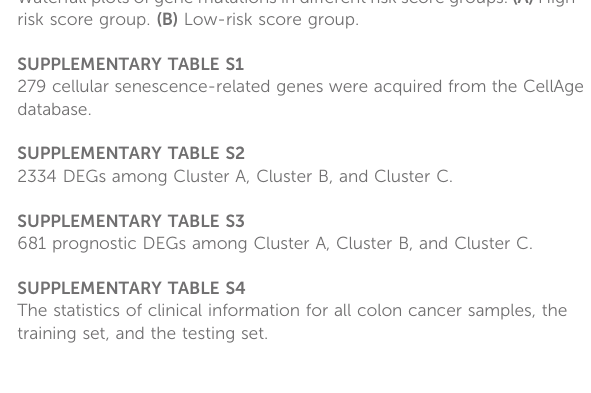
SUPPLEMENTARY FIGURE S1 The design fl ow chart for the research. SUPPLEMENTARY FIGURE S2 Clustering results based on the expression of 279 cellular senescence- relatedgenes.ClusterNum=2,4,5,6,7,8,9.[NotAvailableinCrossRef]. SUPPLEMENTARY FIGURE S3 Identi fi cation of DEGs in clusters. (A) Venn diagram. 2334 DEGs were acquired bytaking intersections of cluster AB, cluster AC, and cluster BC differential genes. (B) Bubble diagram of GO enrichment. BP, biological process; MF, molecular function; CC, cellular component; vertical coordinates represent GO names, horizontal coordinates represent gene proportions; circle size represents the number of genes enriched on GO; circle color represents enrichment signi fi cance. (C) KEGG enrichment bubble diagram. Vertical coordinates represent GO names, horizontal coordinates represent gene proportions; circle size represents the number of genes enriched on GO; circle color represents enrichment signi fi cance. SUPPLEMENTARY FIGURE S4 Clustering results based on the expression of 681 prognostic DEGs amongclusters.ClusterNum=2,3,4,5,6,7,8,9.WhenclusterNum=3, the relationship in the gene cluster was tight and the correlation between gene clusters was weak. SUPPLEMENTARY FIGURE S5 (A – D) ROC curves for the risk score signature of Ren, Wang, Zhang, and Zheng for predicting 1-, three- and 5-years survival in patients with colon cancer. (E – H) Patients with colon cancer were classi fi ed into high and low-risk score groups based on the risk score signature of Ren, Wang, Zhang, and Zheng. Patients in the low-risk score group had a better prognosis. SUPPLEMENTARY FIGURE S6 Waterfall plots of gene mutations in different risk score groups. (A) High- risk score group. (B) Low-risk score group. SUPPLEMENTARY TABLE S1 279 cellular senescence-related genes were acquired from the CellAge database. SUPPLEMENTARY TABLE S2 2334 DEGs among Cluster A, Cluster B, and Cluster C. SUPPLEMENTARY TABLE S3 681 prognostic DEGs among Cluster A, Cluster B, and Cluster C. SUPPLEMENTARY TABLE S4 The statistics of clinical information for all colon cancer samples, the training set, and the testing